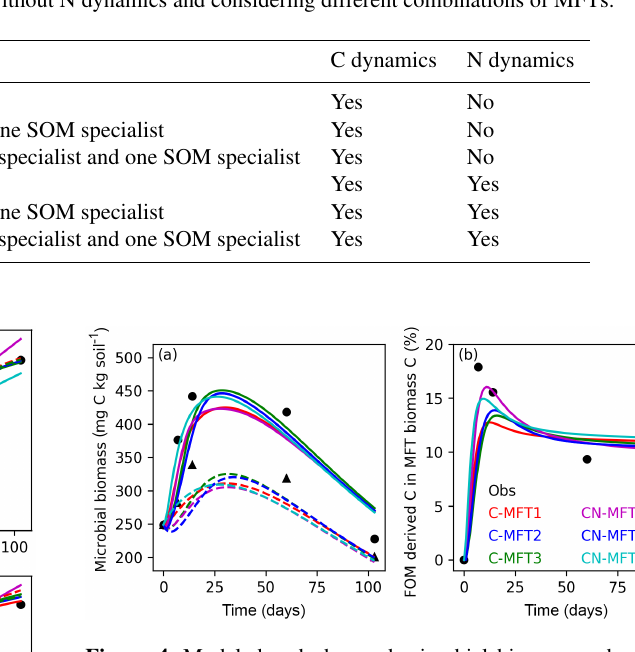
Table 6. Descriptions of the six ORCHIMIC variants with or without N dynamics and considering different combinations of MFTs.